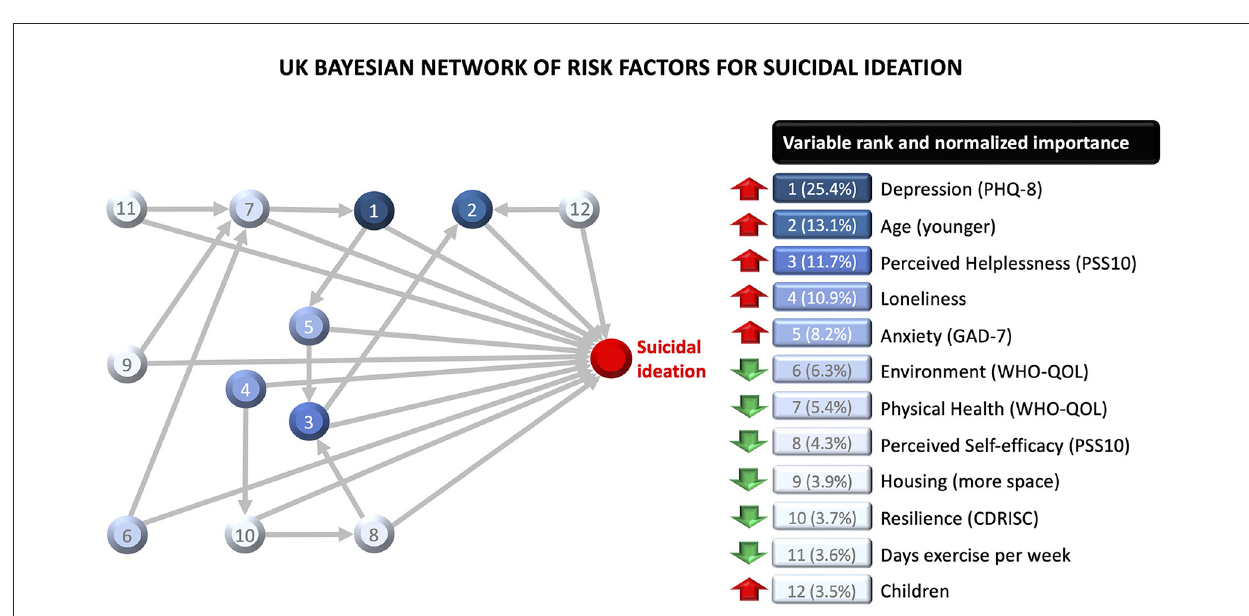
FIGURE3 Bayesian network model for the British sample, with variable importance indices for each variable. The red upward arrows denote risk factors for suicidal ideation, and the green downward arrows denote protective factors. The model also shows two-way interactions between variables.